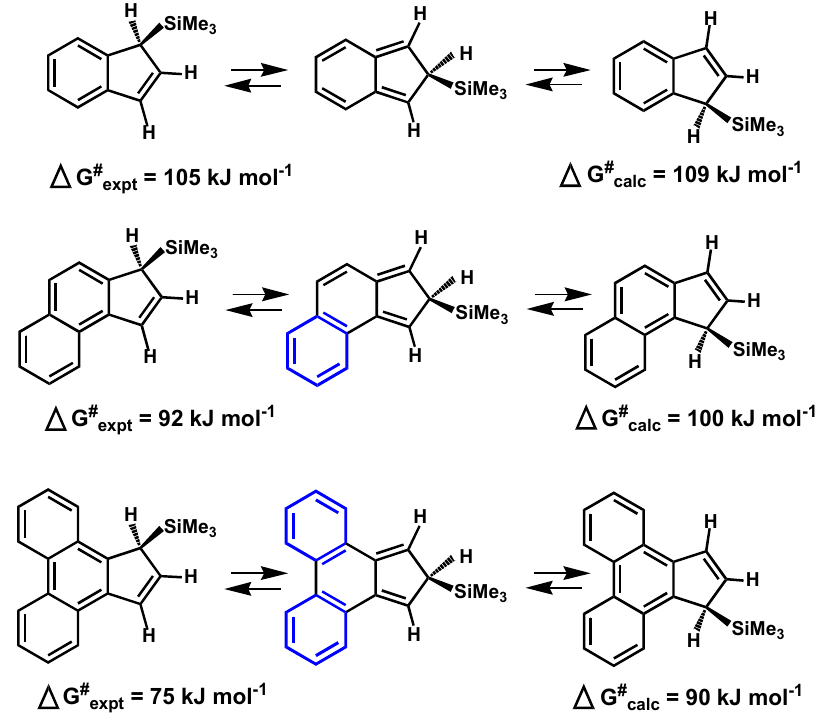
Figure 4. Calculated and experimental barriers to silatropic shifts in a series of benzindenes.